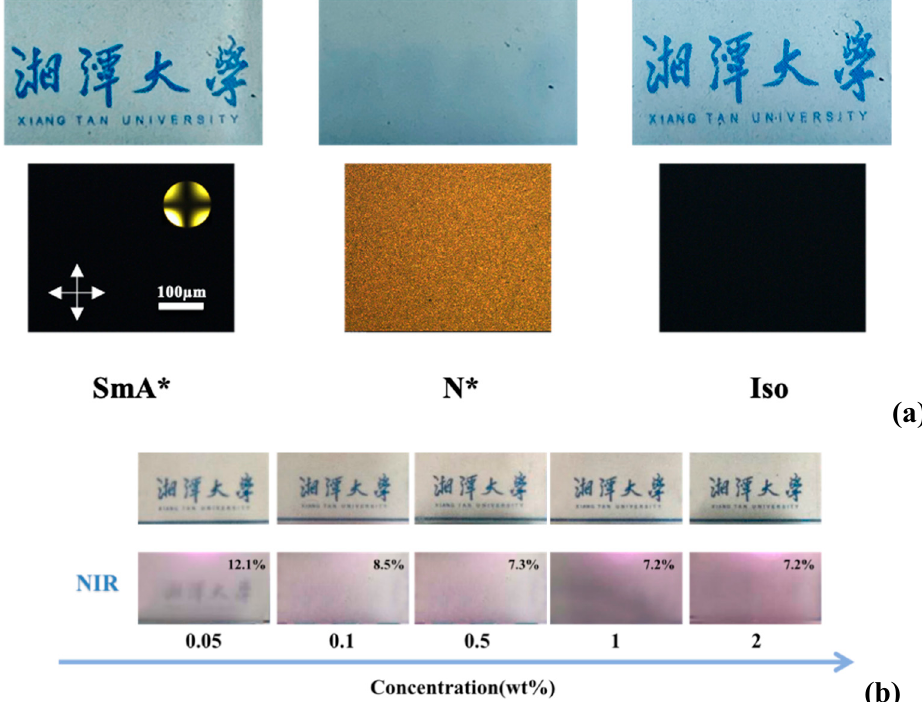
Figure 7. ( a ) The images of the fabricated PSLC cell in the SmA*, N*, and Iso phases. ( b ) Images of the fabricated PSLC cells with different polymer brush concentrations before and under NIR irradiation (27 °C, the incident height: 3 cm). Upper right corner: transmittance value at 550 nm after NIR irradiation.